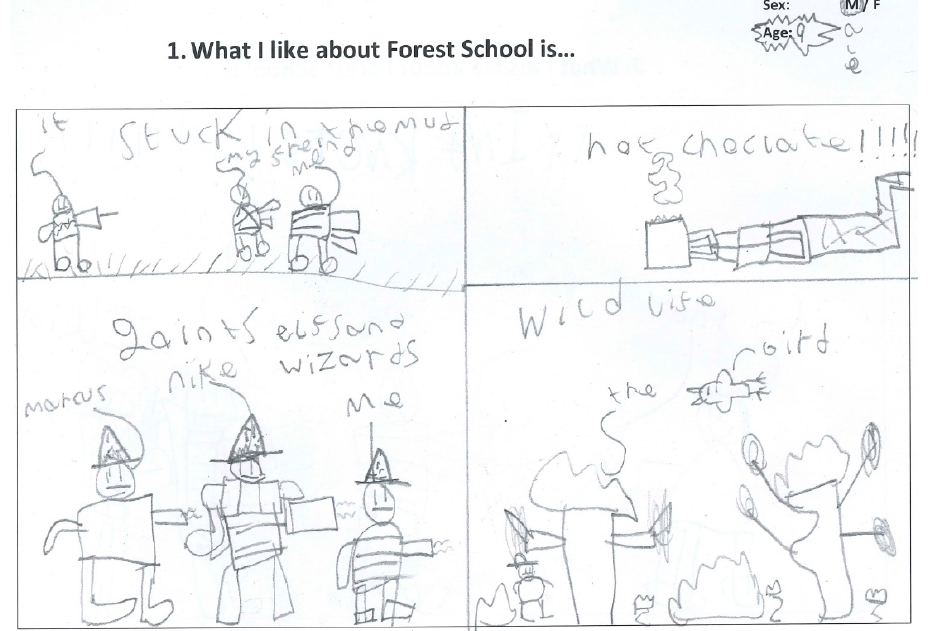
Figure 2. Drawing to illustrate boys’